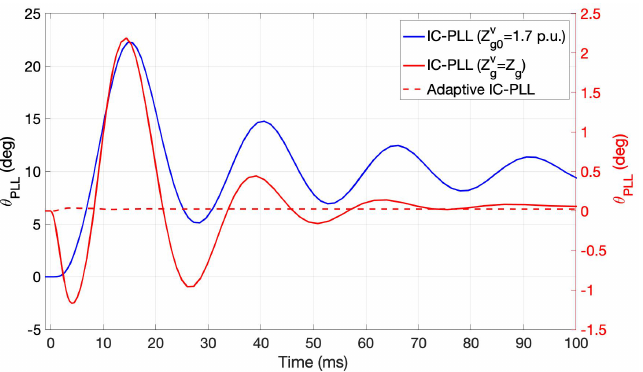
Figure 13. Time-domain response of the θ PLL for different types of PLLs for step change in Z g = 1.7 2 p.u. and for ω FL , PLL = 400 rad/s (inverter →